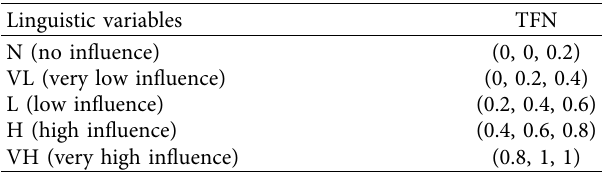
Table 2: Semantic transformation table.